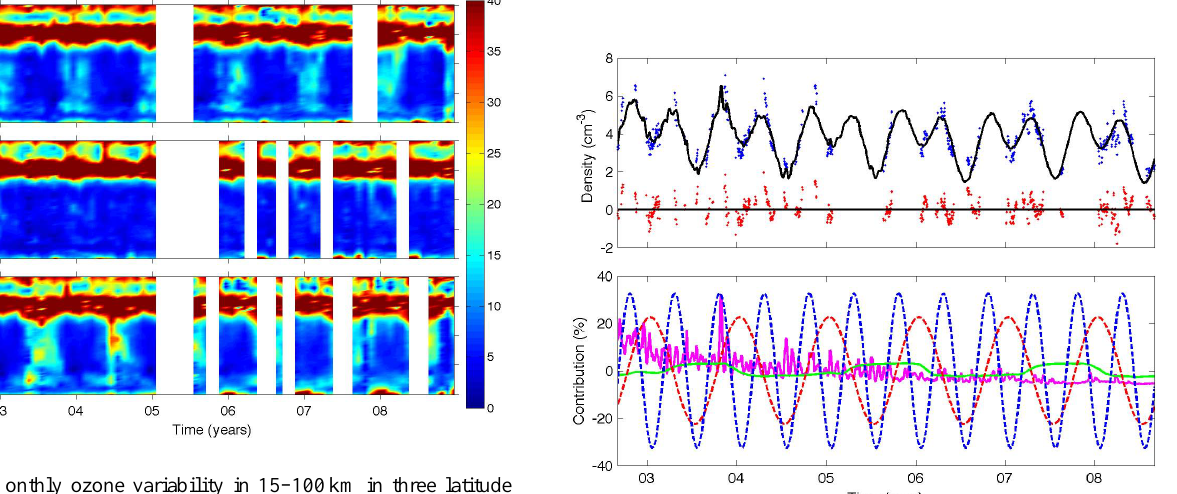
Fig. 7. Monthly ozone variability in 15–100km in three latitude belts as a function of time and altitude. The variability shown is the quartile distance of data subtracted by the quartile distance of the retrieval errors (the factor 1/1.349 of Eq. (1) included). The values are relative to the median values and in %. Latitude belts: 30 ◦ N– 50 ◦ N (top), 10 ◦ S–10 ◦ N (middle), 30 ◦ S–50 ◦ S (bottom).